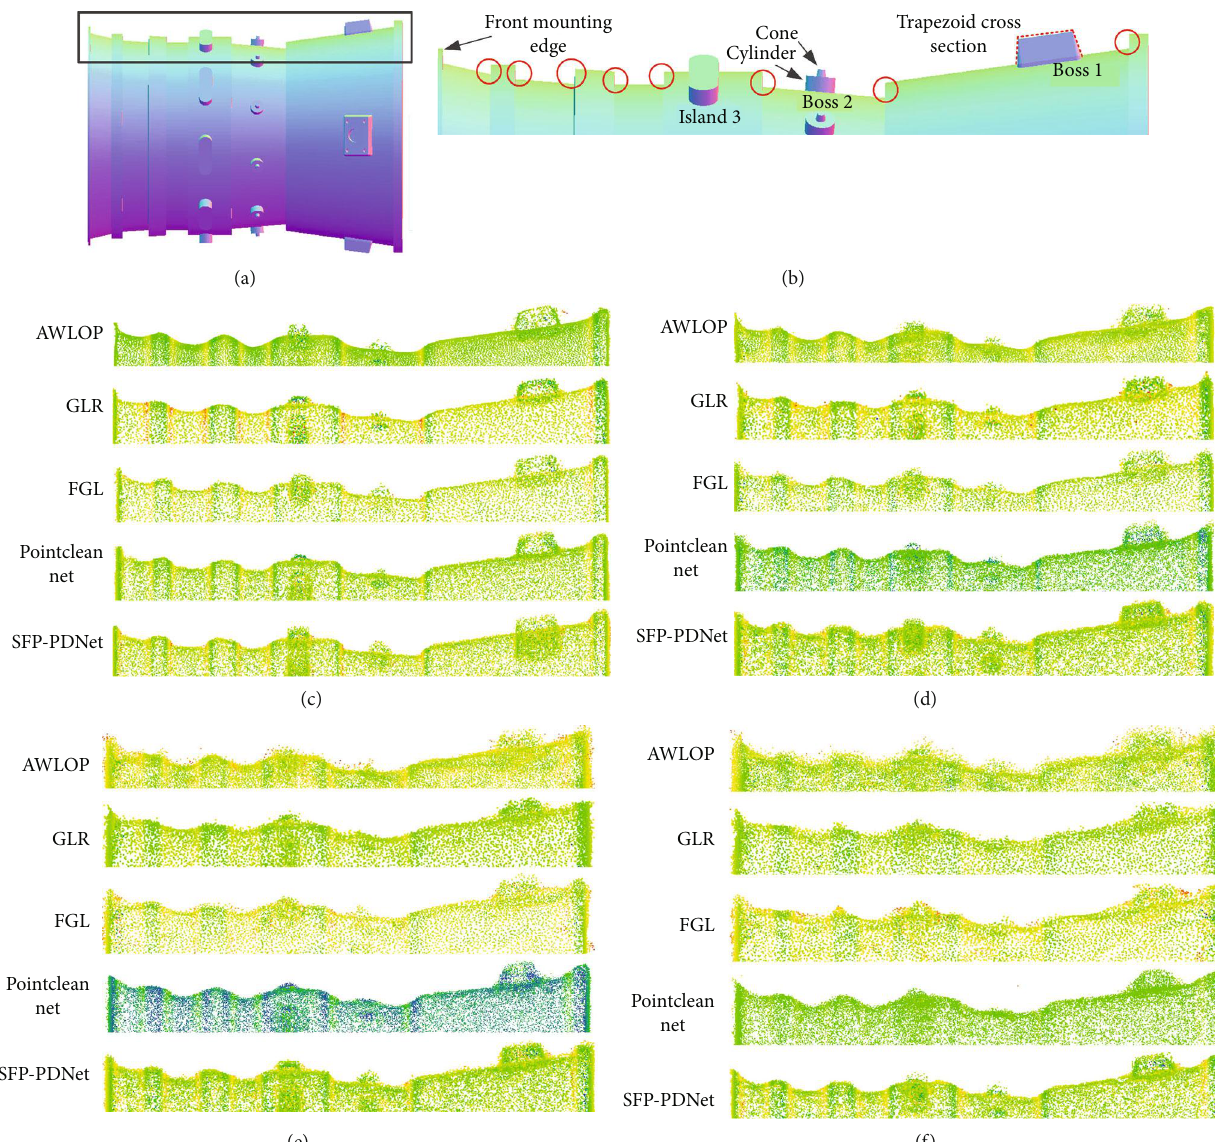
Figure 23: The larger versions of qualitative comparison. (a) original triangle mesh (b) the larger version of features (c)0.5% b (d)1.0% b (e)1.5% b (f)2.0%